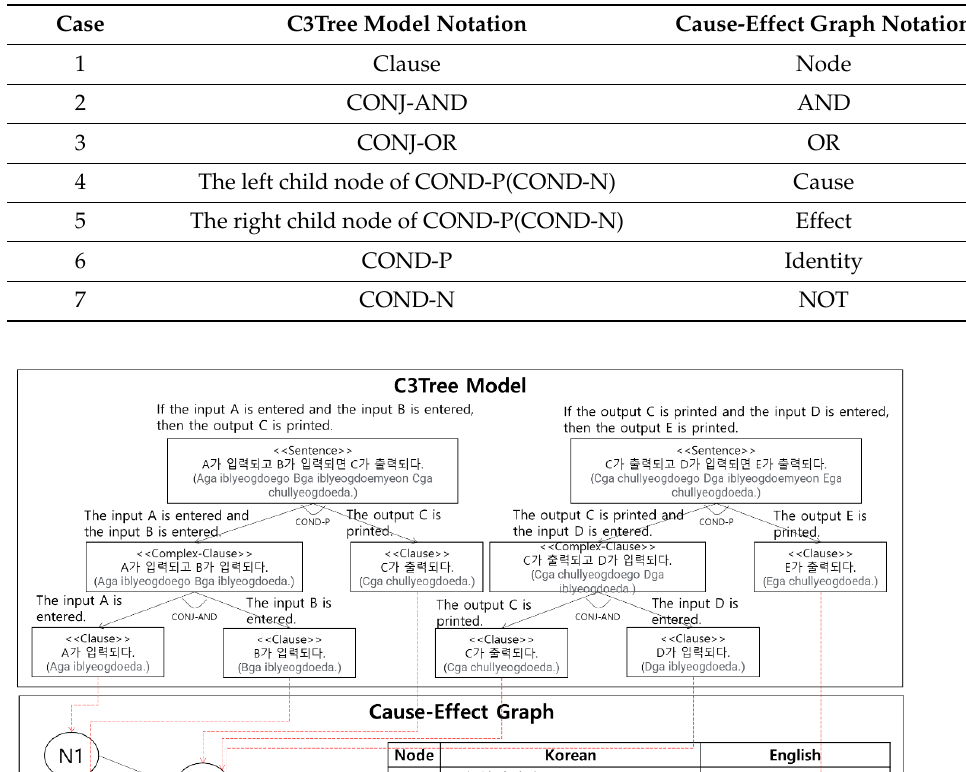
Table 10. Relationship between C3Tree Model Notations and Cause-Effect Graph Notations.